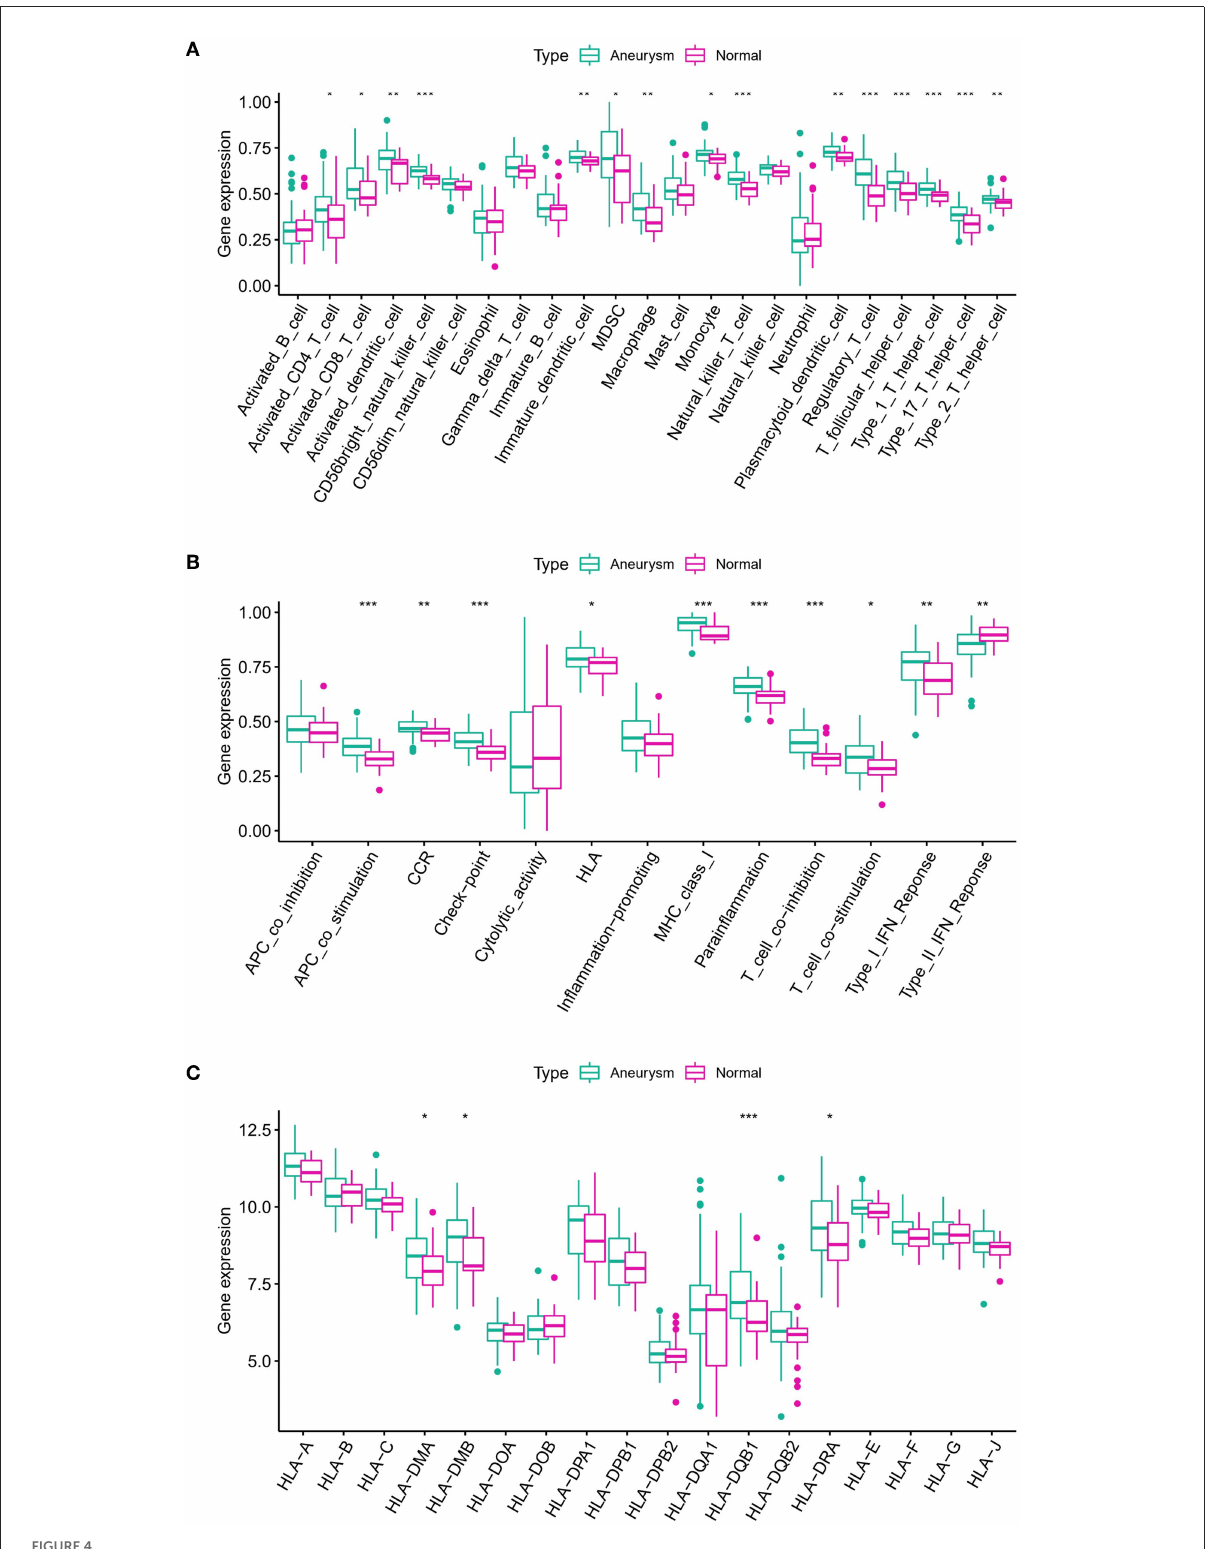
FIGURE4 (A) Differences in the abundance of 23 infiltrating immunocytes. (B) Differences in the activity of 13 immune response gene sets in IA and normal subtypes. (C) Differences in the expression of 18 HLA genes between IA and normal subsets. The symbols * , ** , and *** indicates the value of p < 0.05, p < 0.01, and p < 0.001